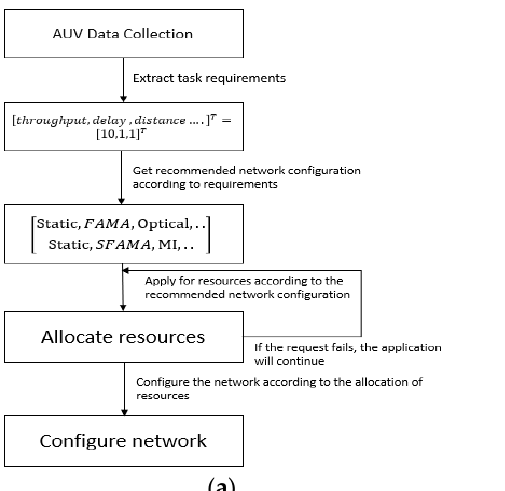
Figure 15. ( a ) Emergency data request for underwater detection application; ( b ) detailed information of interaction between emergency task terminals of underwater environmental monitoring network.